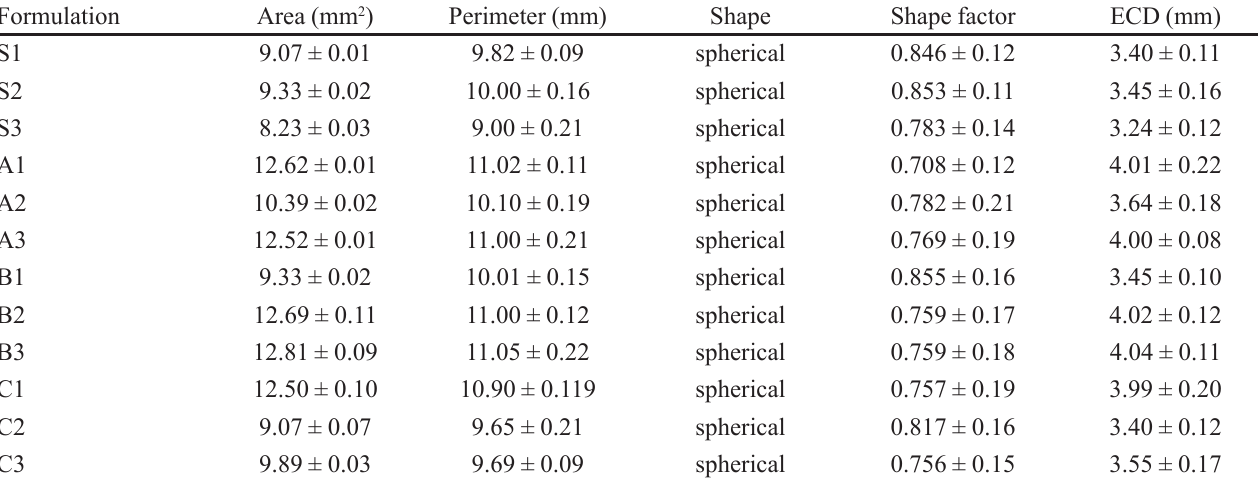
TABLE II - Shape parameters of the different formulations